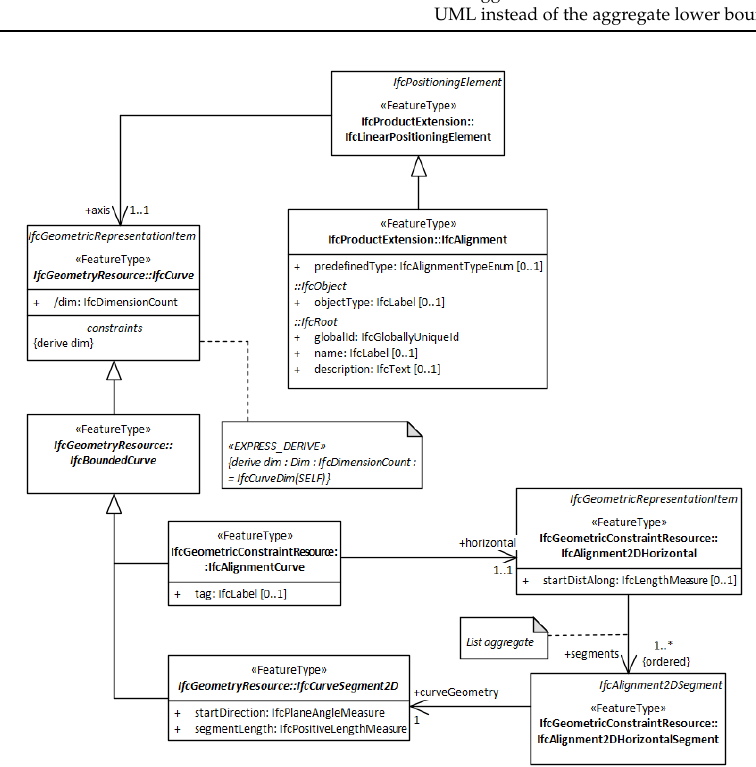
Figure 8. UML class diagram showing examples of IFC attributes converted to UML.